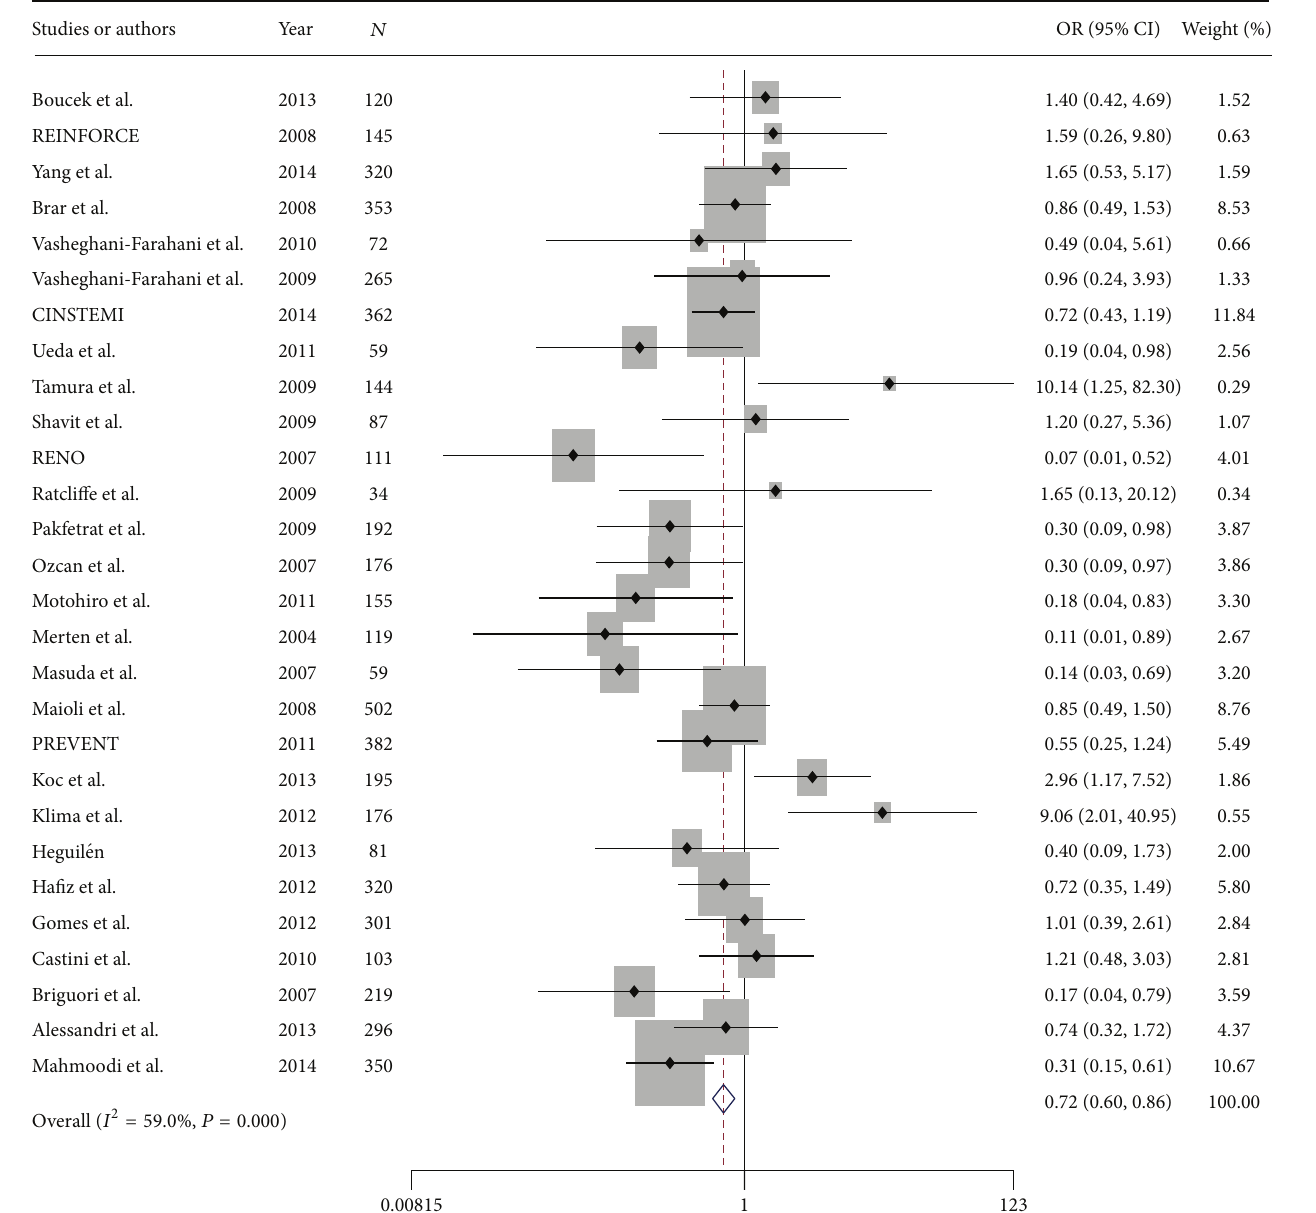
Figure 1: Forest plot of odds ratio (OR) for hydration with sodium bicarbonate on contrast-induced nephropathy.